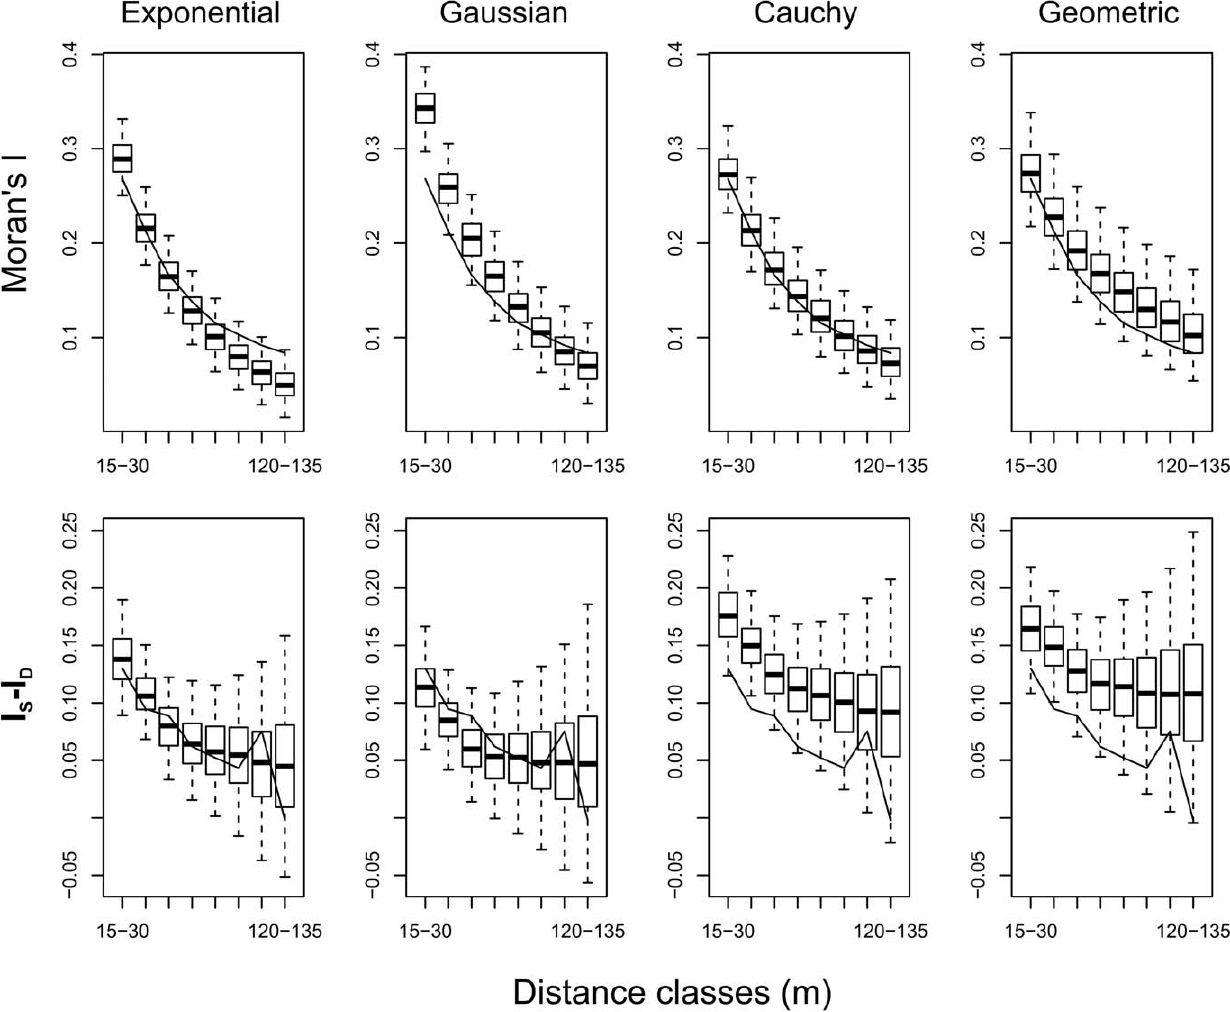
Figure 4. Spatial autocorrelation of data simulated with the Gaussian Field Latent Class model of Triatomainfestans distribution. The autocorrelation of infestation in the generated data is compared to the autocorrelation in observed data. Infestation data were generated on the validation map using the estimated parameters for each of the kernels: exponential (first column), Cauchy (second column), Gaussian (third column), and geometric (fourth column). We calculated the standard Moran’s I (first row) and the difference I S { I D between within block and across street autocorrelation (second row) as a function of distance. The solid line indicates the values for the observed data. Box plots indicate the values obtained from generated data. The boxes indicate the 25 th , 50 th and 75 th quantiles, and the whiskers depict the 95%